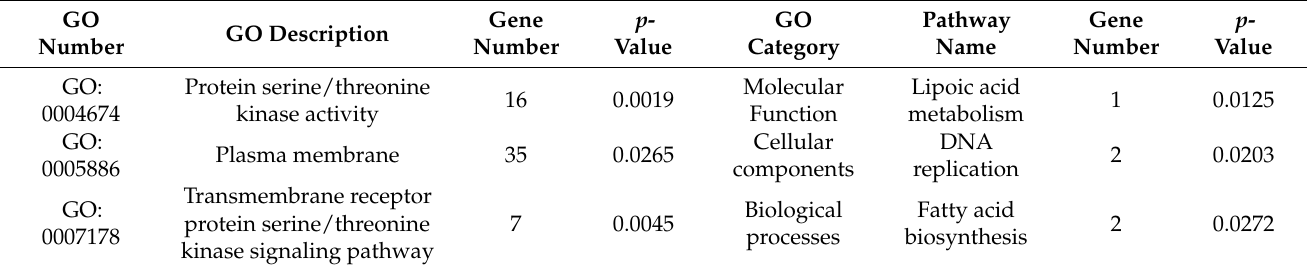
Table 4. CK versus ALA comparator group-specific differential alternative splicing genes significantly enriched in GO entries and KEGG pathway.